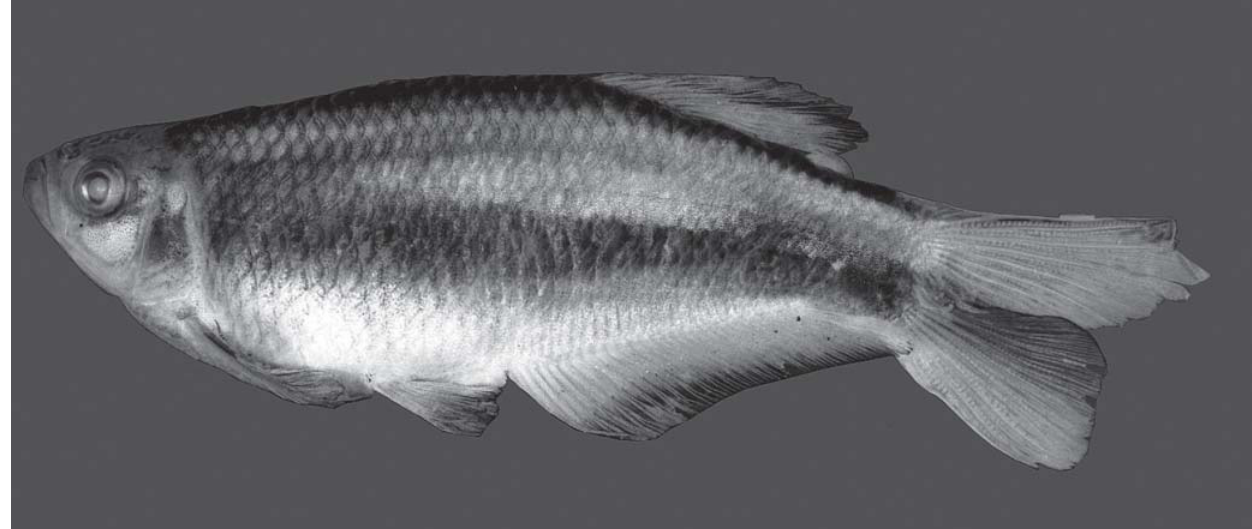
Fig. 78. Mimagoniates microlepis , large adult male, USNM 249888, 53.3 mm SL, Brazil, São Paulo State, rio Biguá near